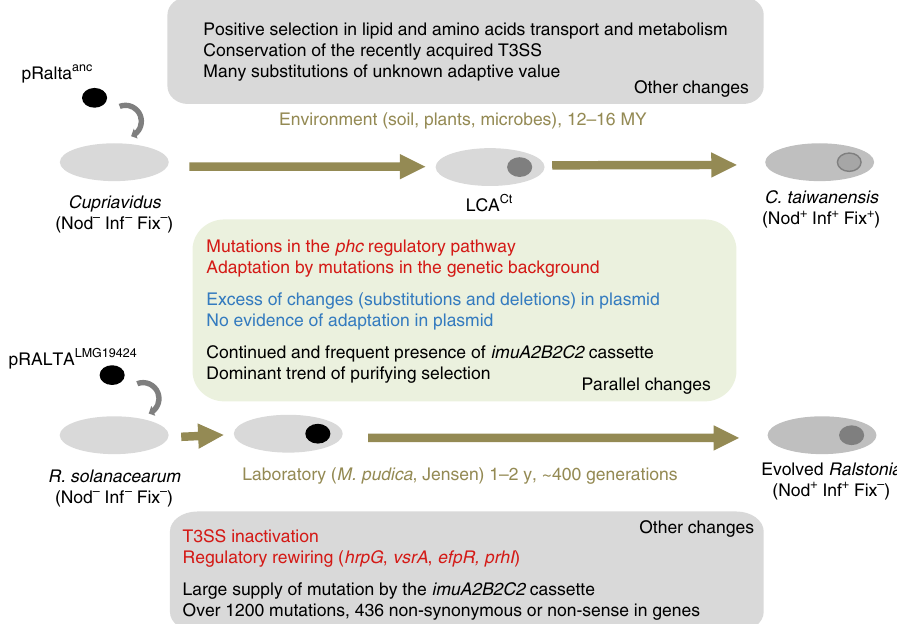
Fig. 5 Overall similarities and differences between the experimental and natural evolutionary processes described in this study. Known adaptive and non-adaptive changes are in red and blue,